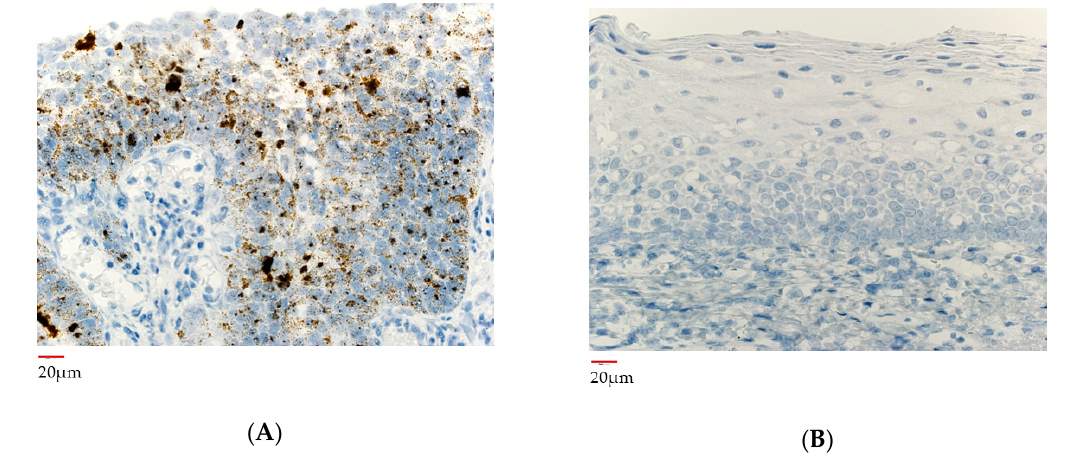
Figure 6. The findings of high-risk HPV viral antigens in RNA in situ hybridization. ( A ) Biopsy specimen of the primary tumor before neoadjuvant chemotherapy showing expression of high-risk HPV genotypes. ( B ) Surgical specimen of the primary tumor after neoadjuvant chemotherapy showing no signals of high-risk HPV genotypes.